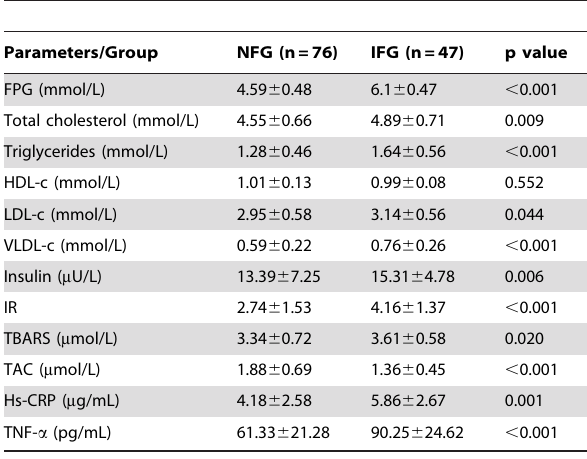
Table 3. Comparison of cardiac autonomic function test (supine) parameters between NFG and IFG group.